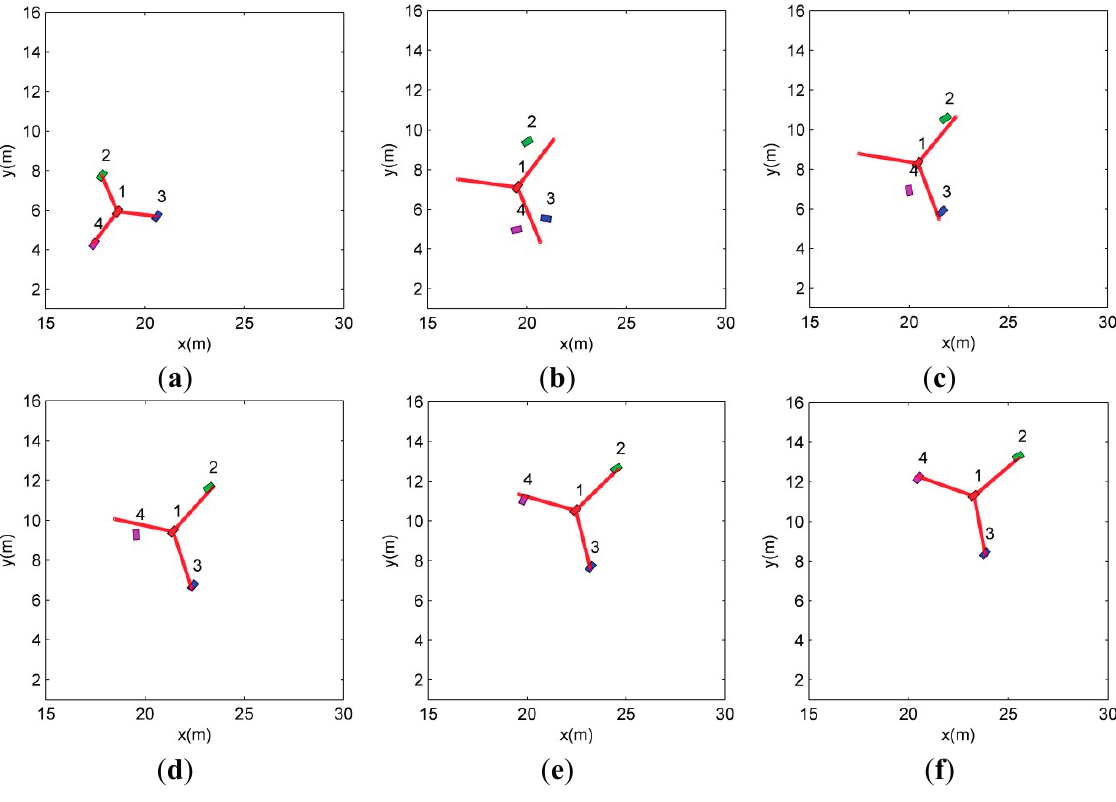
Figure 9. The movements of the member robots at the moment of the formation